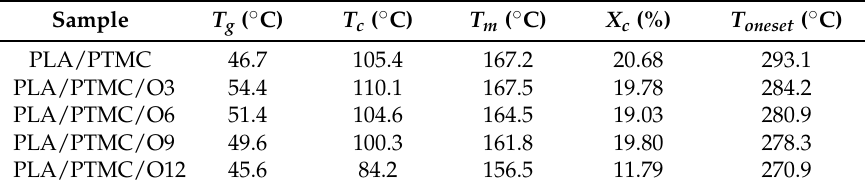
Table 1. The thermal properties of PLA/PTMC/OEO composite films.